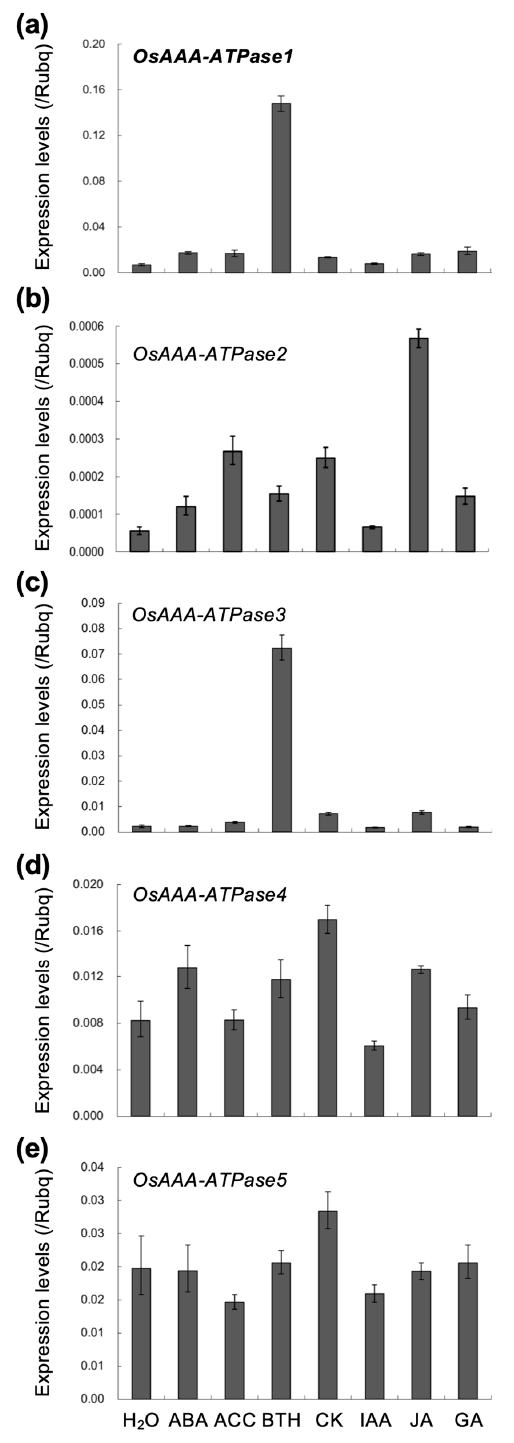
Figure 2. Expression analysis of OsAAA-ATPase1–5 ( a – e ) in response to the plant hormones abscisic acid (ABA), ethylene (ACC, an ethylene precursor), benzothiadiazole (BTH, a functional analogue of SA), kinetin (CK, a synthetic cytokinin), auxin (IAA), jasmonic acid (JA), and gibberellic acid (GA), in Nipponbare rice seedlings. Data are represented as means ±